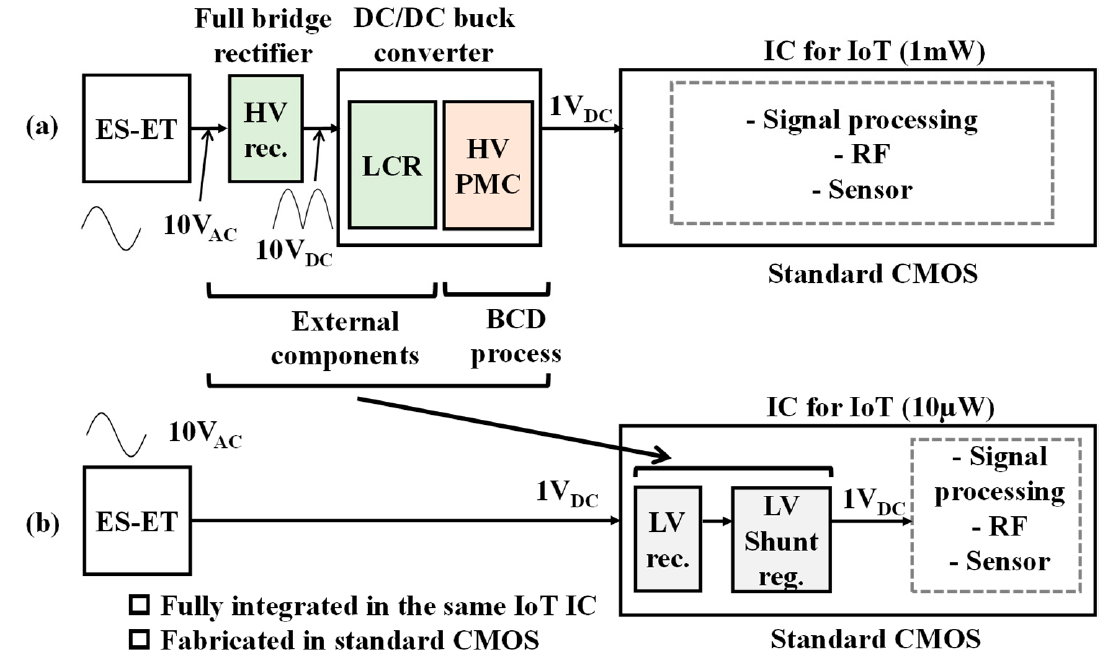
Figure 1. IoT edge device with an ES-ET and ( a ) a buck converter with FBR and PMC in a BCD process [6] or ( b ) a proposed shunt regulator integrated into an IoT chip.